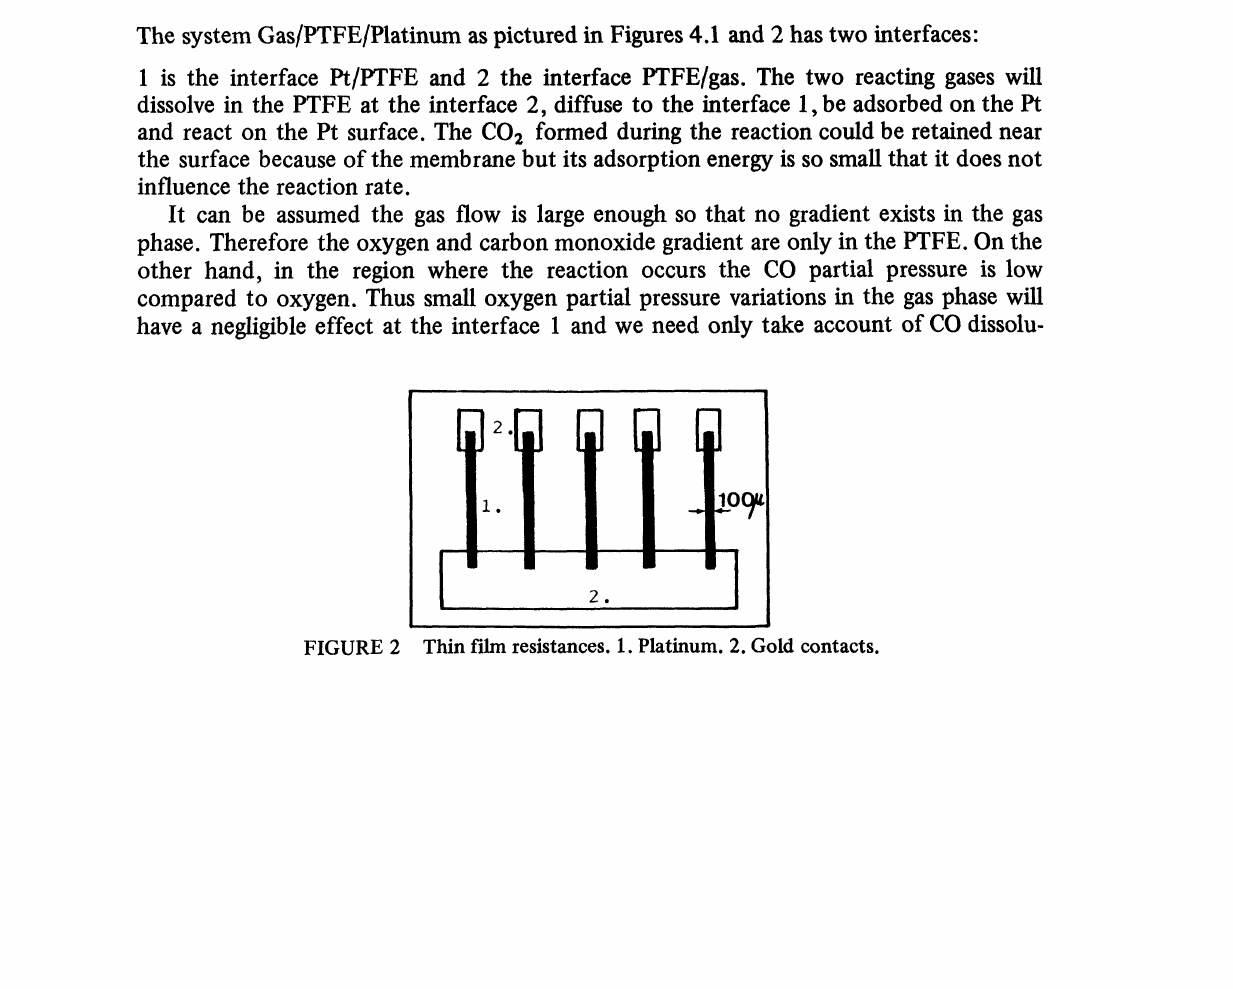
FIGURE 2 Thin film resistances. 1. Platinum. 2. Gold